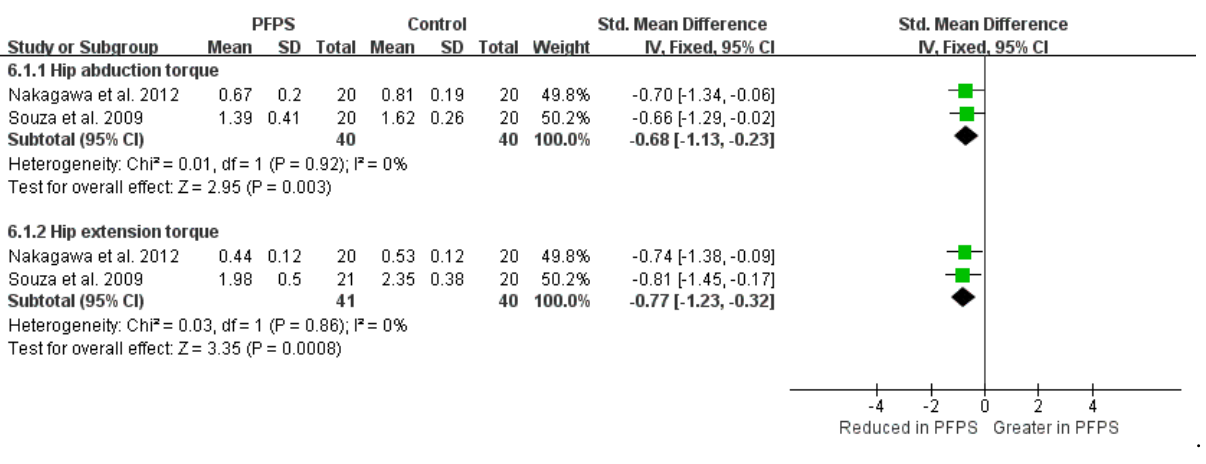
Figure 9. Hip torque.